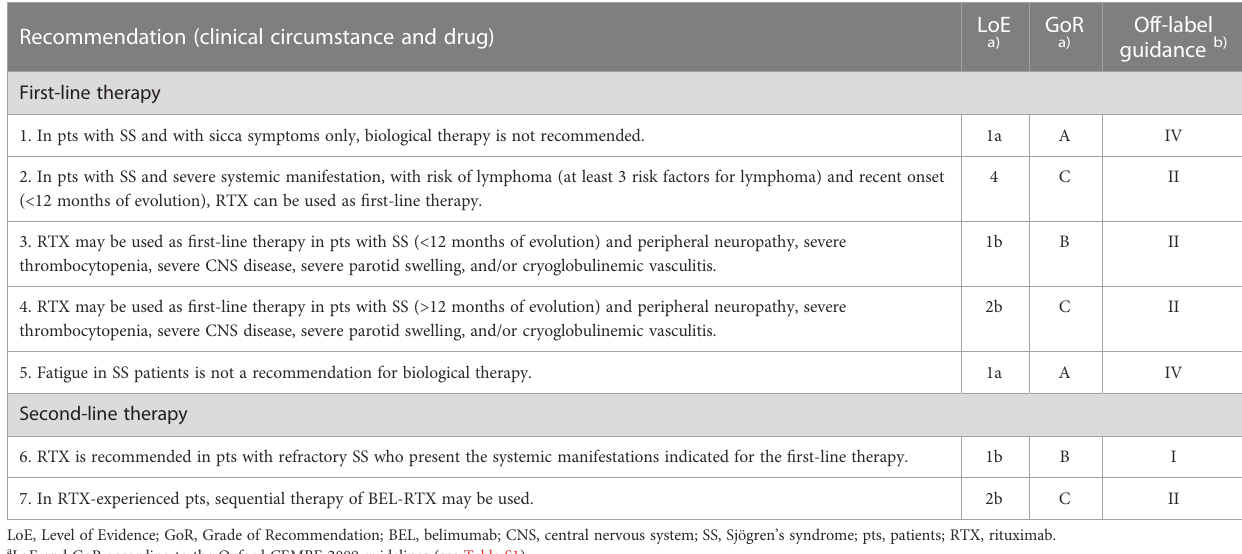
TABLE 4 Recommendations for the off-label biological therapy in Sjögren ’ s syndrome.